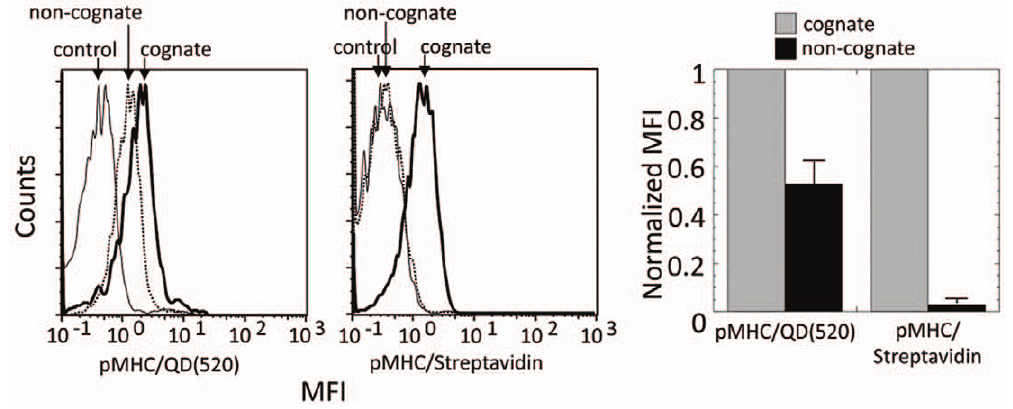
Figure 1. Noncognate pMHC assembled on QD but not on Streptavidin scaffold stain CD8 CTL. Left panel: Staining of 68A62 with cognate (bold solid line) and noncognate (dotted line) pMHC oligomers is shown; staining with the noncognate oligomers containing HLA-A2 with A245V mutation in nonpolymorphic domain (solid line) was used as a negative control. Right panel: Normalized MFI of 68A62 CTL incubated with cognate IV9-HLA-A2/QD(520) and IV9-HLA-A2/Streptavidin are compared with that of noncognate Tax-HLA-A2/QD(520) and Tax/Streptavidin oligomers. Data represent mean 6 s.d.